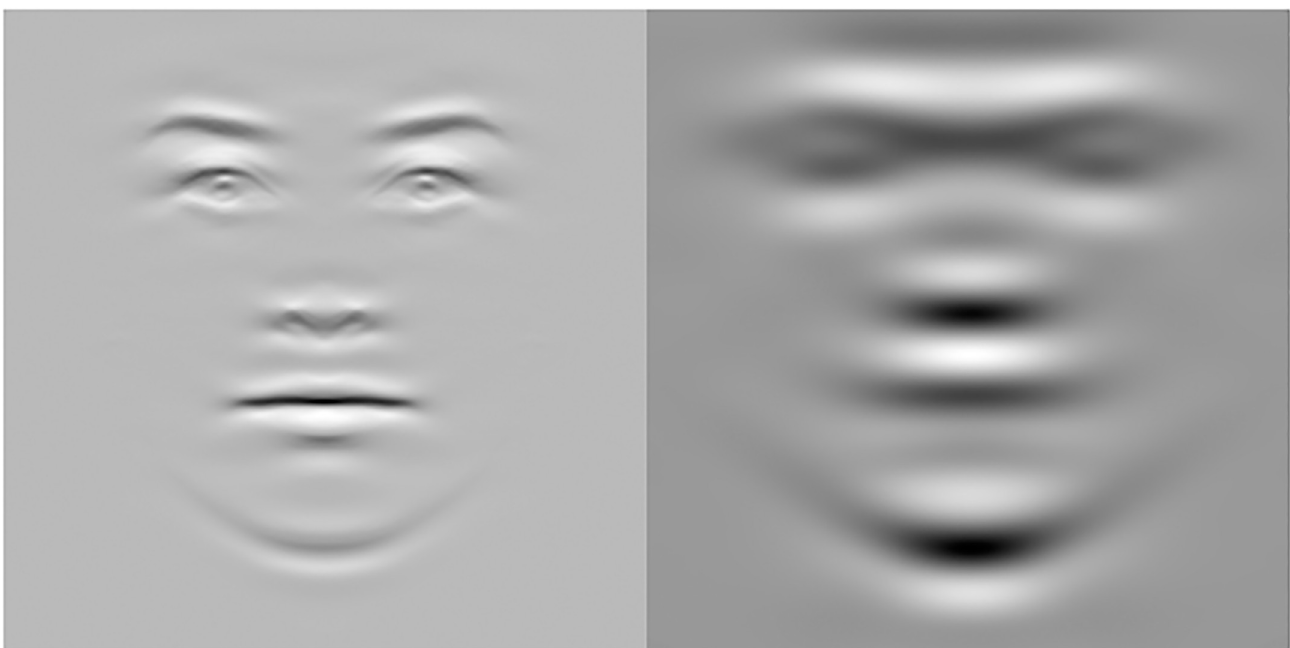
Fig 11. Graphic representations, based on the means of all female and male faces from the Oslo Face Database, of the spatial frequencies significantly correlated with the normative ratings of attractiveness.